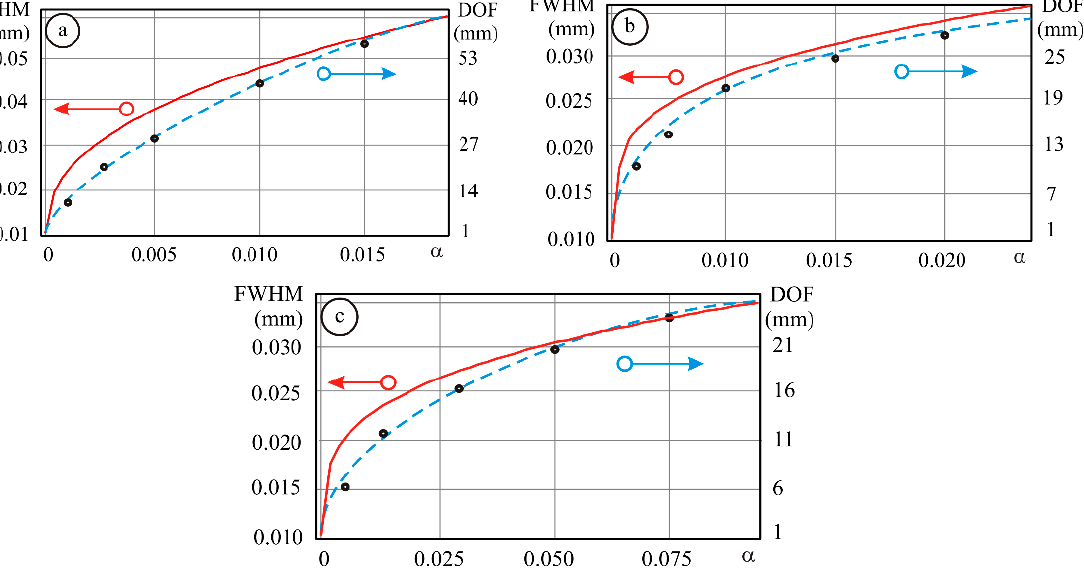
Figure 5. Graphs of the dependence of the central light spot size in the focal plane (solid line) and DOF (dashed line) on the coefficient α : ( a ) n = 3, ( b ) n = 4, and ( c ) n = 5.